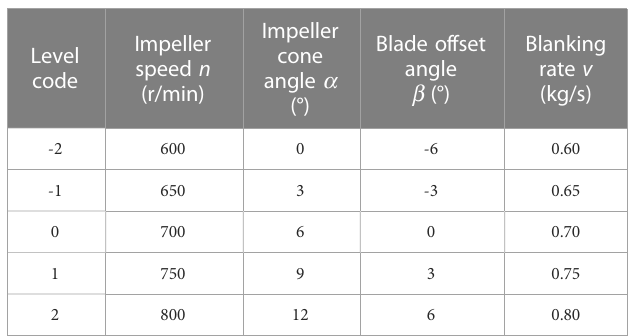
TABLE 1 Factor level coding table. TABLE 2 Test scheme and